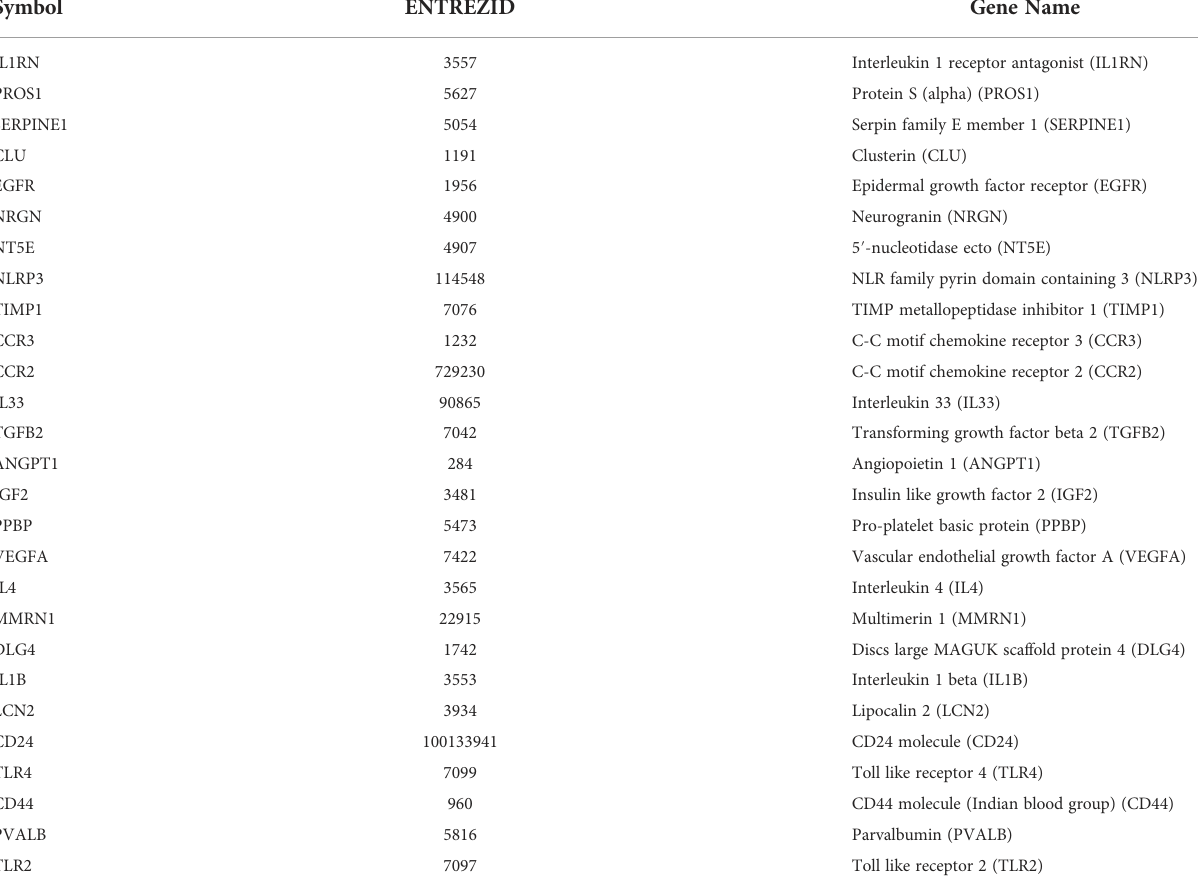
TABLE 3 The 27 Hubgenes of three clusters. Symbol